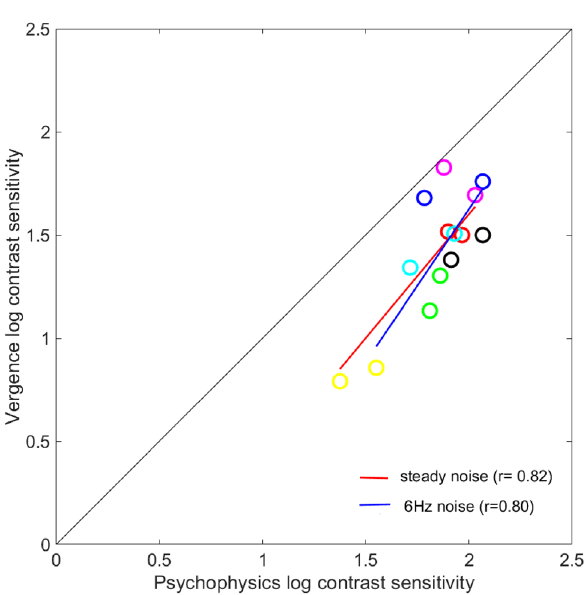
Figure 4. Scatter plot showing peak vergence contrast sensitivity vs psychophysical contrast sensitivity at 2 cpd. Circle color represents the subjects, there are two circles for each subject, one that is for steady and one for flicker noise, red slanted line represents regression line for steady noise and blue line represents 6 Hz noise regression line, the solid dark slanted line represents a 1:1